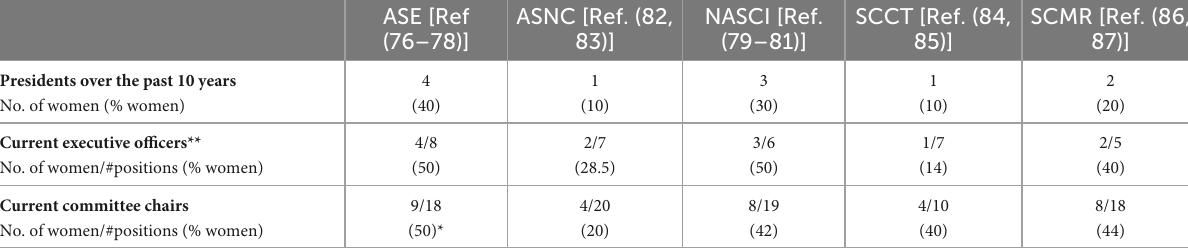
TABLE 1 Female leadership participation in the major US-based cardiovascular imaging